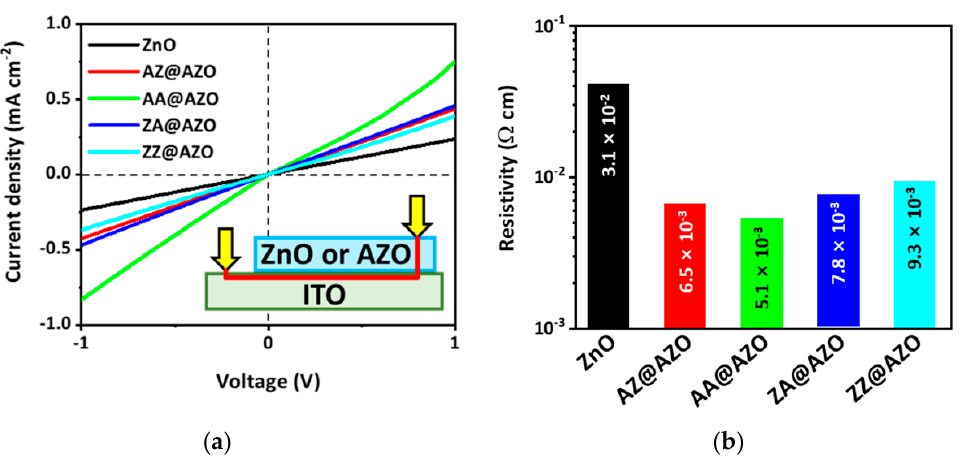
Figure 3. ( a ) I-V graphs of ZnO and AZO overlayers on ITO substrates; ( b ) Resistivity values from the 4-point probe method of 20-nm-thick ZnO and AZO thin films on glass substrates.